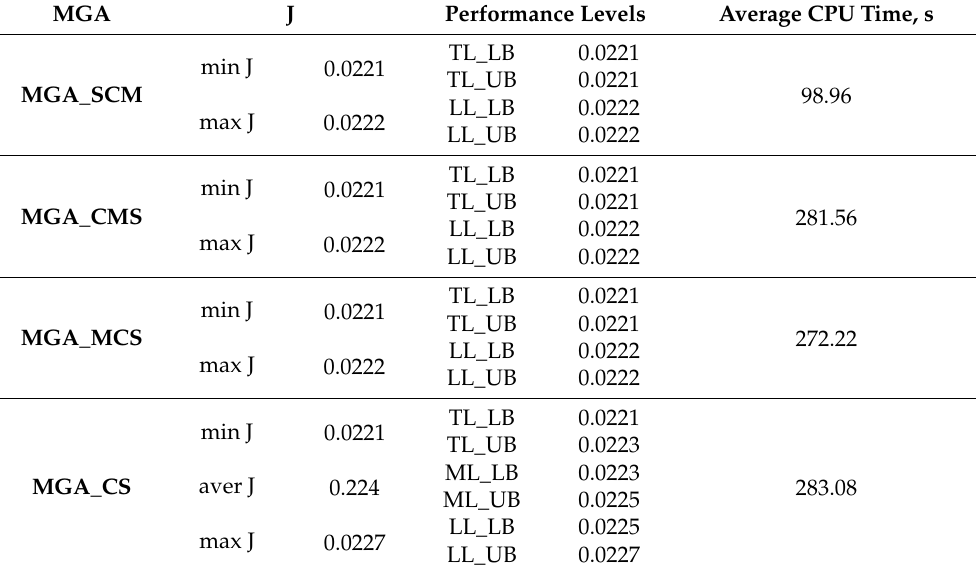
Table 1. Performance of the four investigated types of MGA. MGA J Performance